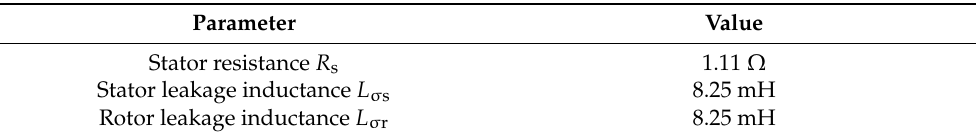
Table 2. Values of parameters of tested machine used for calculations obtained by standard tests specified in [13].